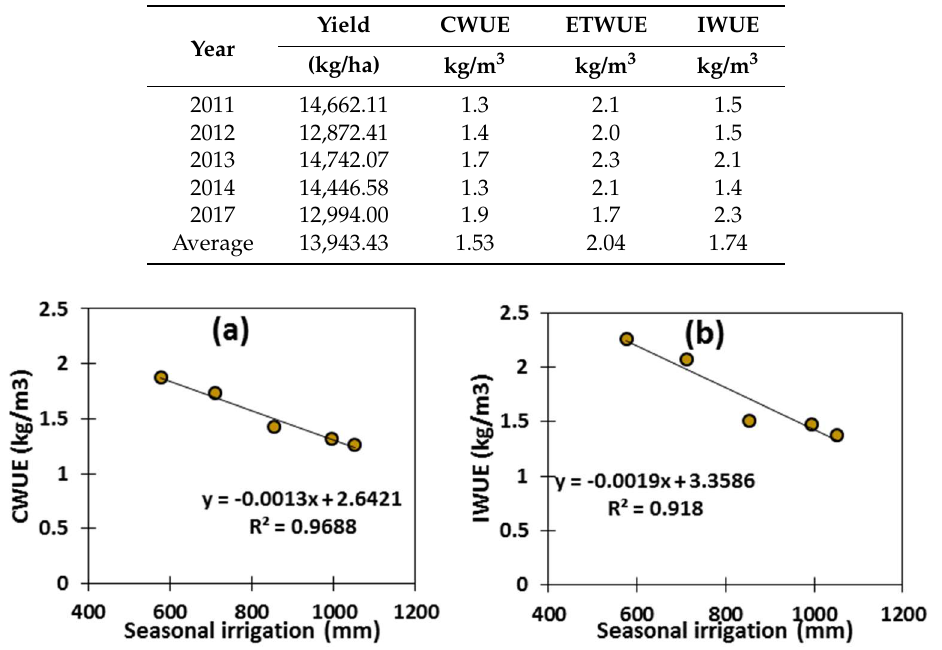
Figure 6. Relationship between maize seasonal irrigation amount and ( a ) crop water use efficiency and ( b ) irrigation water use efficiency.